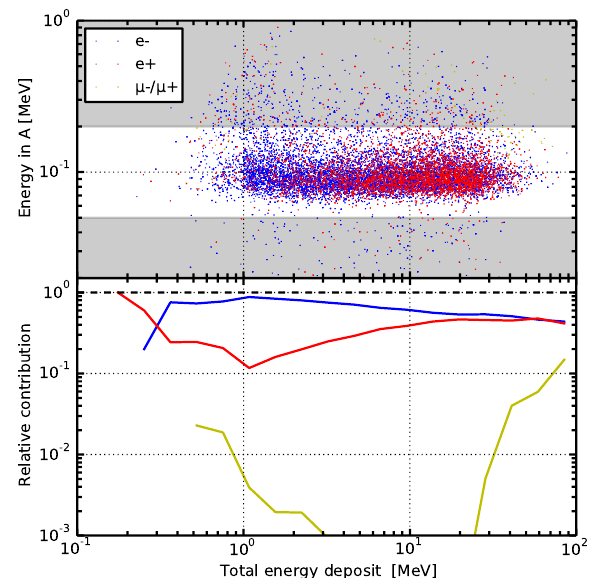
Figure 3. Top: simulated RAD stopping charge particle measure- ments for isotropic distributions of electrons (blue), positrons (red), muons and anti-muons (yellow) with spectra obtained from Plan- etocosmics simulations. The white area (between 50 and 200keV energy in A) marks the selection criterion for the RAD elec- tron/positron measurement. Bottom: the expected energy dependent contribution of electrons, positrons and muons to the measurement.